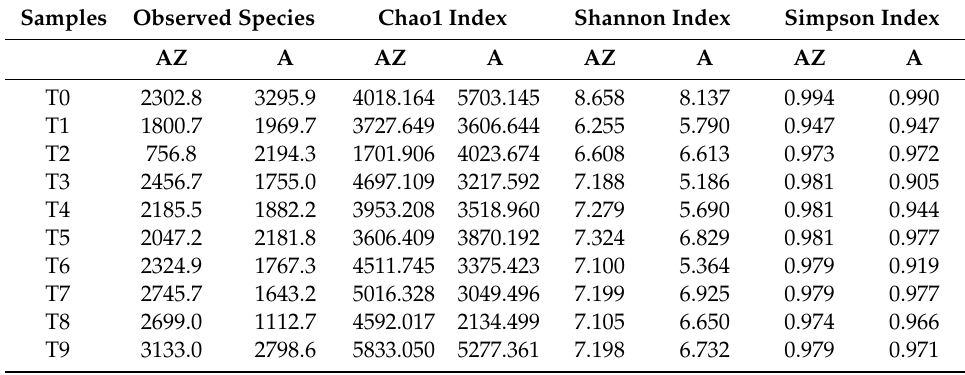
Table 3. Microbial richness and diversity of 16S rDNA libraries based on 90% identity of operational taxonomic units (OTUs) from Amarillo Zamorano and Antilope silages samples.